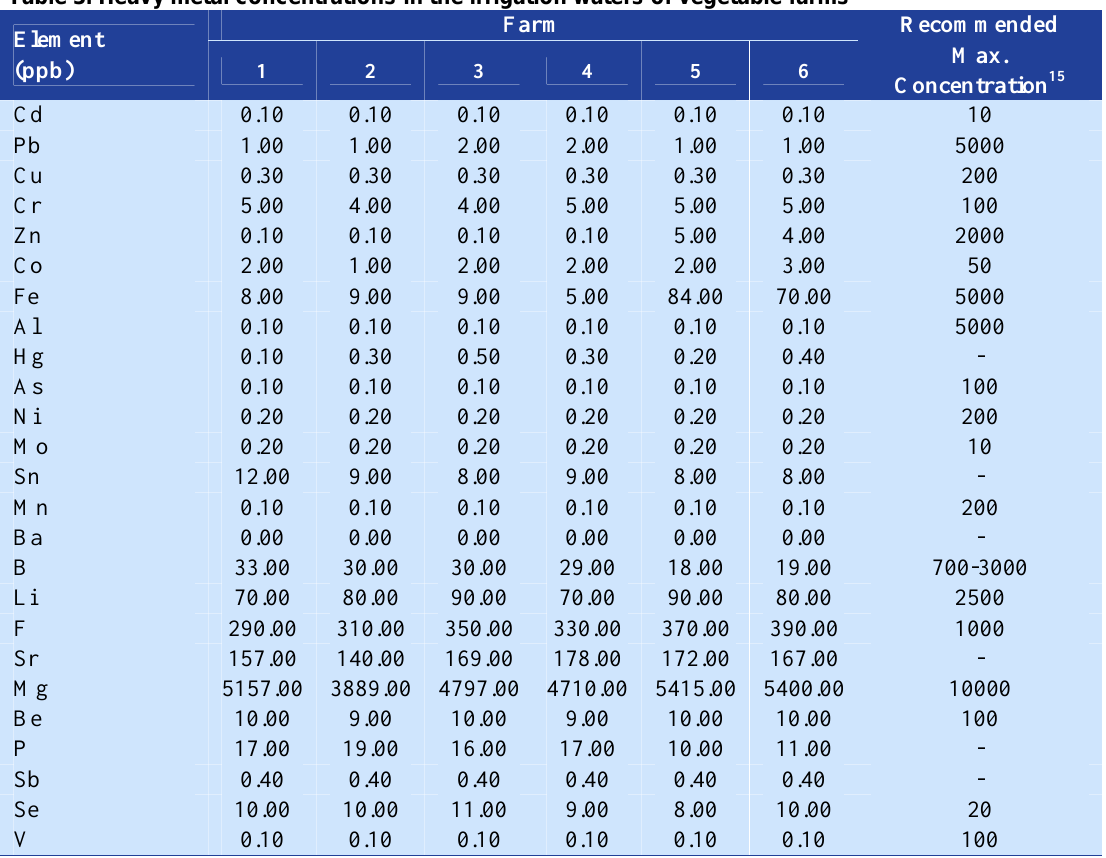
Table 3. Heavy metal concentrations in the irrigation waters of vegetable farms